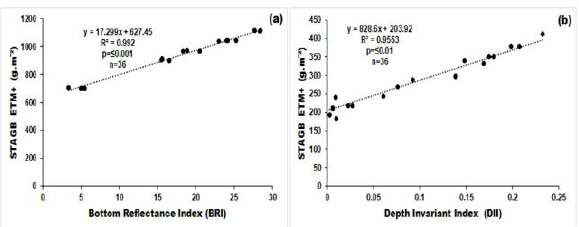
Figure 4. The established relationship between seagrass indexes with STAGB quantified empirically from the Landsat ETM+ imageries of a) STAGB vs BRI b and b) STAGB against DII acquired after water column correction in